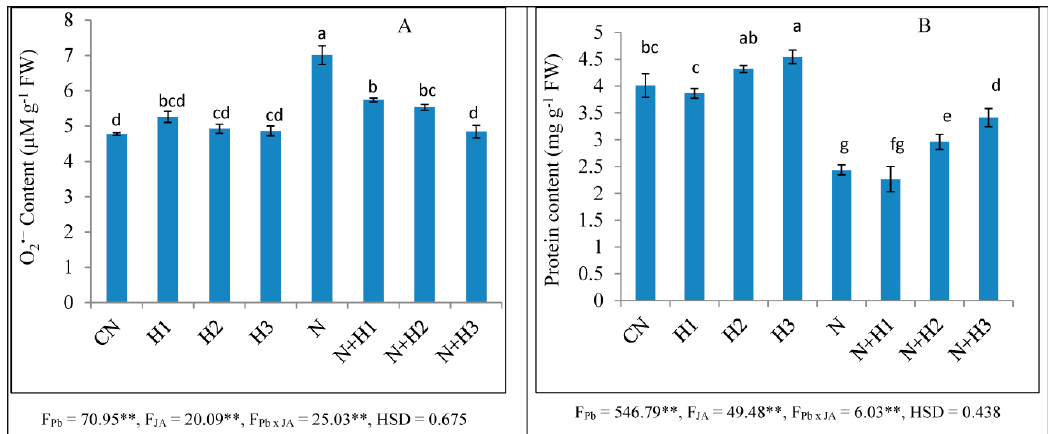
Figure 1. Effect of seed soaking treatment of JA (0.01, 1, and 100 nM) on O 2 • − and protein contents in tomato seedlings after seven days of nematode inoculation. CN = control, H1 = 0.01 nM JA, H2 = 1 nM JA, and H3 = 100 nM JA. (Mean ± SD, two-way ANOVA, Tukey’s HSD). Means with similar letters are not significantly different from each other. * and ** designated significance at p ≤ 0.05 and p ≤ 0.01, respectively.